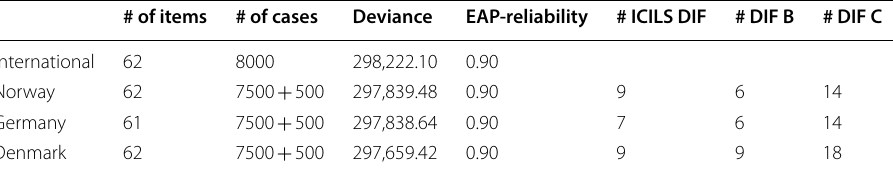
Table 1 Key parameters from the Rasch analyses # of items Number of cases is 8000 in all analyses. In the DIF-analyses 500 students from the country under investigation and 7500 students from other countries are included